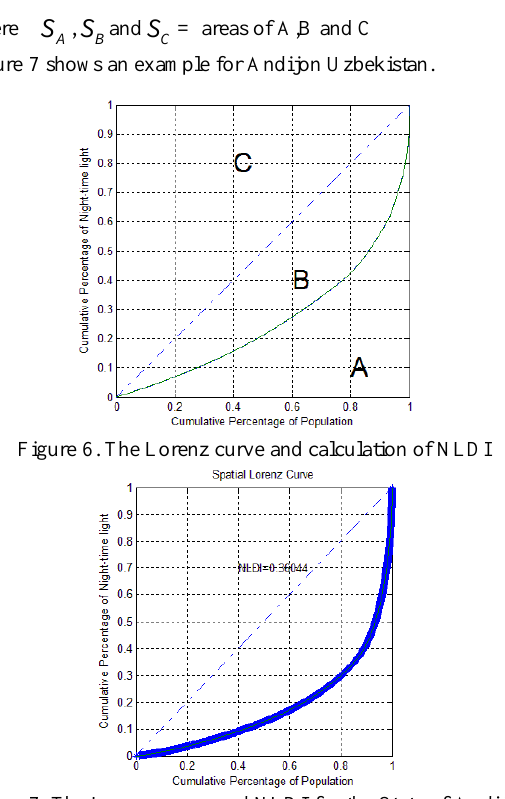
Figure 7. The Lorenz curve and NLDI for the State of Andijon,